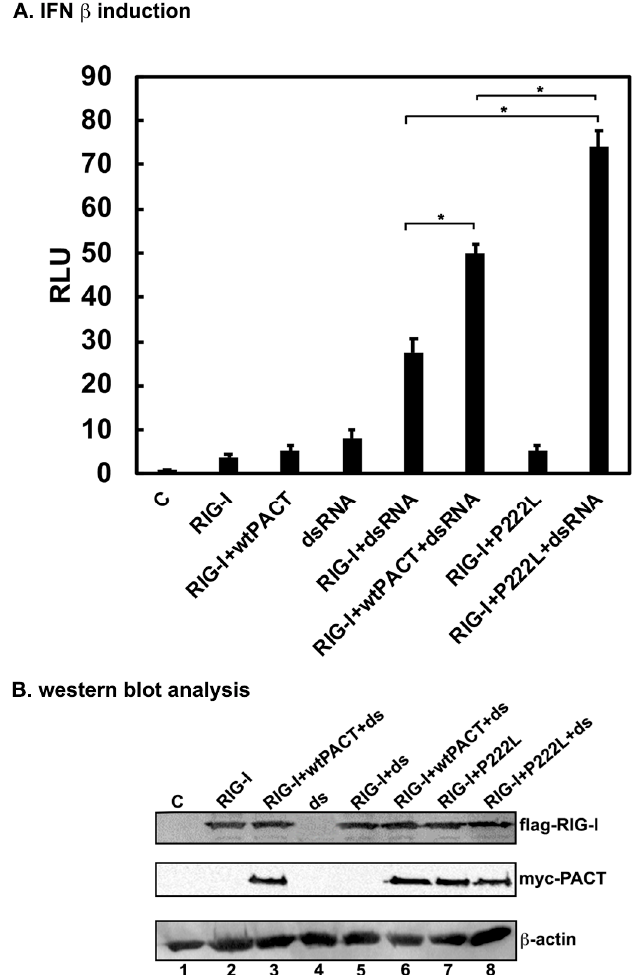
Figure 2. P222L mutation augments PACT and RIG-I-mediated IFN β production in response to low molecular weight (LMW) polyI:C. ( A ) HEK293Ts were transfected with IFN- β -Luc reporter alone (C and ds), or IFN- β -Luc reporter and expression construct for flag-RIG-I, and either 50 ng of myc-tagged wt PACT or P222L mutant expression construct as indicated, then treated with polyI:C 24 h after transfection as indicated (dsRNA). pRLnull plasmid was co-transfected in all samples for nor- malization of transfections. Cell extracts were assayed for dual luciferase activity 16 h after polyI:C treatment. The p -values based on 3 independent experiments that were <0.001 and are denoted as significant with an asterisk. ( B ) Western blot analysis of transfected cells. Whole cell extracts pre- pared at 24 h from transfected cells were analyzed by Western blot analysis. The samples 1–8 corre- spond to the order of samples in part A. Blots were probed with anti-flag, anti-myc, and anti- β -actin antibodies for flag-RIG-I, myc-PACT, and endogenous β -actin used for ensuring equal loading in all lanes.